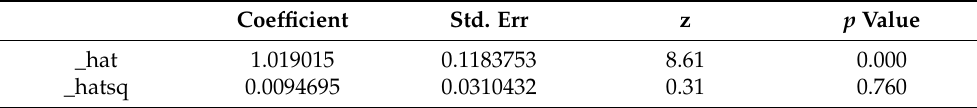
Table 5. Specification error